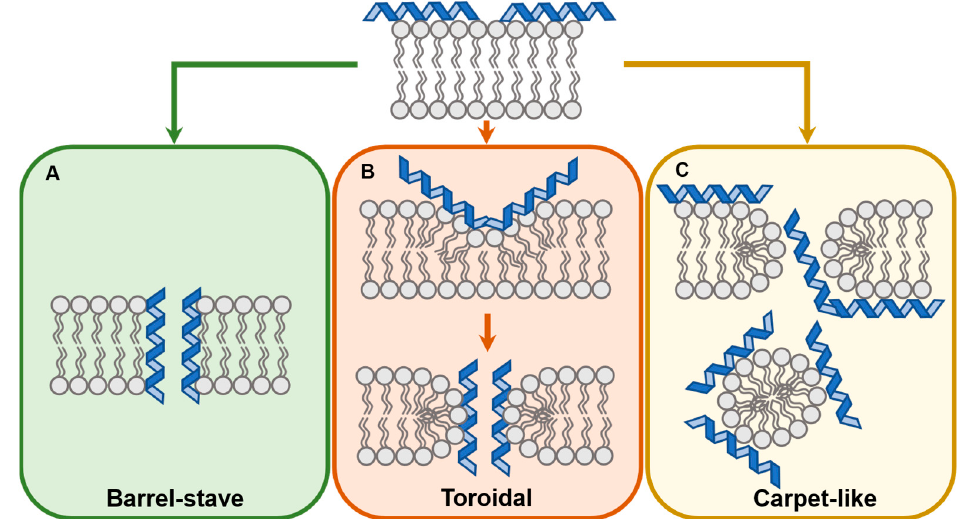
Figure 1. Proposed mechanisms of membrane penetration. The initial interaction of a membrane active peptide occurs with the phosphate heads of the outer leaflet of the membrane and is electrostatic. In the barrel-stave model ( A ) the peptide lines perpendicularly along the membrane forming a pore and interacting with the phosphate heads and the fatty acyl chains. In the toroidal pore model ( B ), the peptide induces membrane deformations, causing the temporary fusion of the inner and outer leaflets. The peptide interacts with the phosphate heads. In the carpet-like model ( C ), membrane active peptides cause the disruption of the membrane in a concentration dependent manner. When this critical concentration is reached, membrane-peptide micelles form leading to disruption of the bilayer.